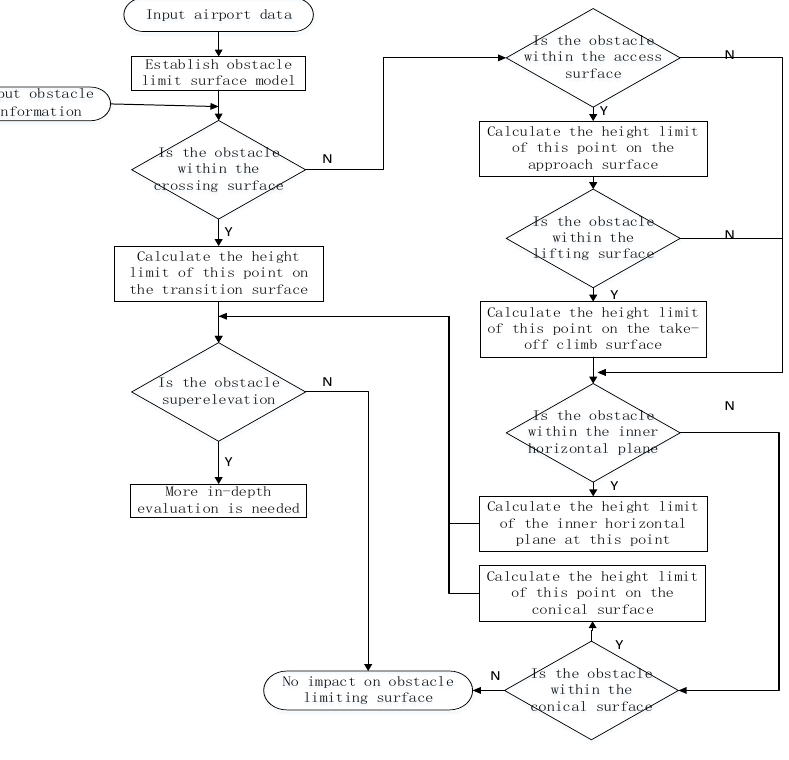
Fig. 1. Schematic diagram of obstacle height